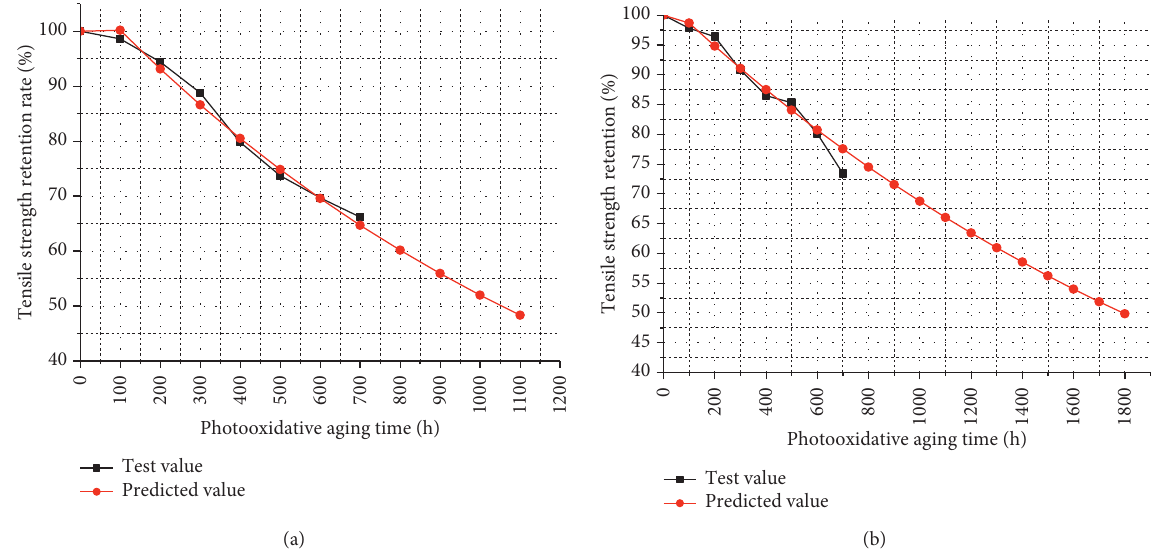
Figure 10: Prediction curves of tensile strength and photooxidation aging time. (a) BG1. (b) BG2.